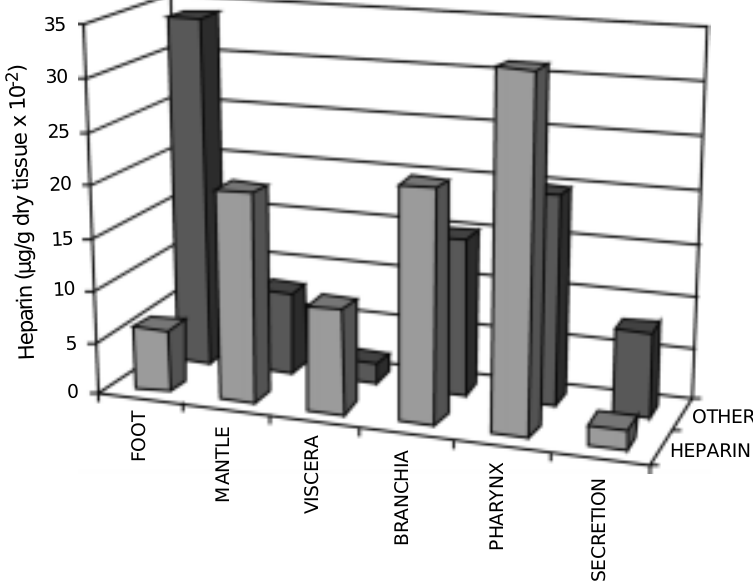
Figure 8 - Distribution of heparin in different tissues of the mollusc Anomalocardia brasiliana . Other, heparan sulfate, chondroitin sulfate and unknown sulfated polysaccharides.